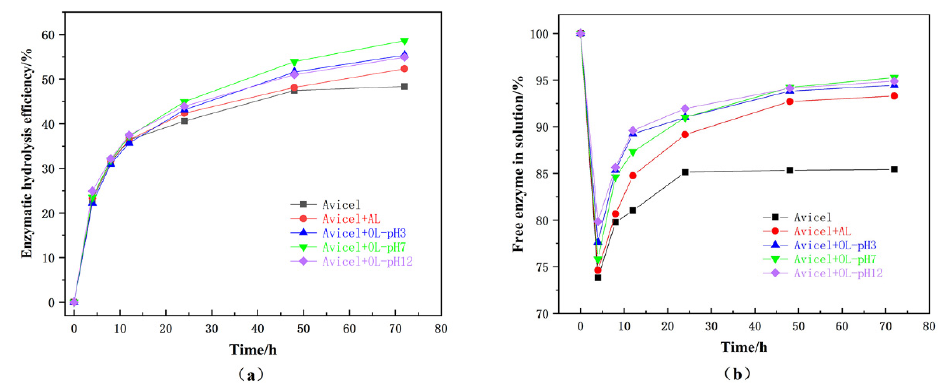
Figure 4. Effects of untreated and ozone pretreated alkali lignin on enzymatic hydrolysis efficiency ( a ) and cellulase distribution ( b ) in enzymatic hydrolysis of Avicel.